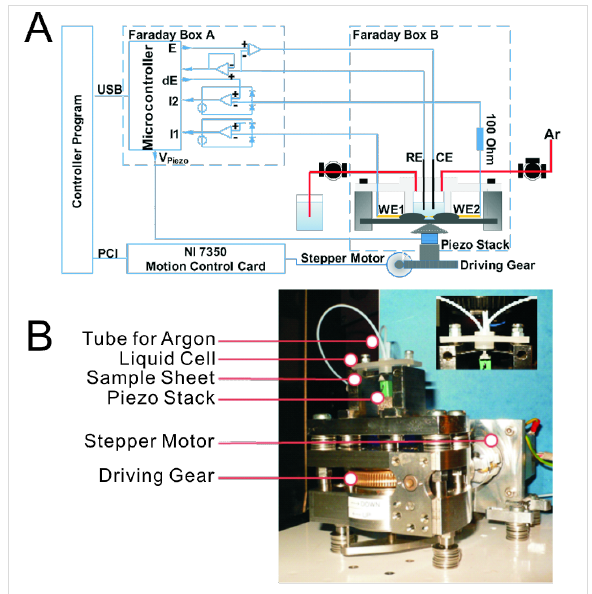
Figure 2: (A) Schematics of the system configuration and (B) pictures of the mechanical part in the MCBJ setup. The inset shows a detailed view of the liquid cell including the sample holder. For clarity, the Faraday shielding boxes were